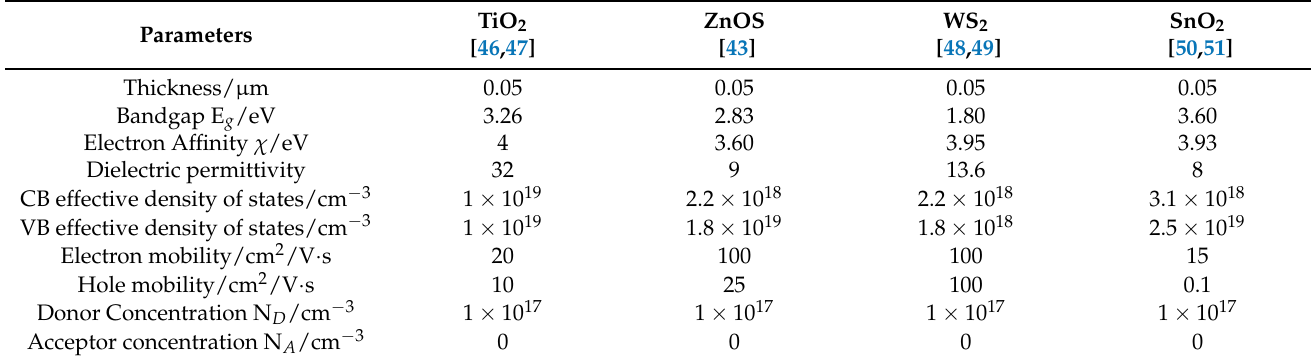
Table 3. Electrical and optical properties of different ETL materials.